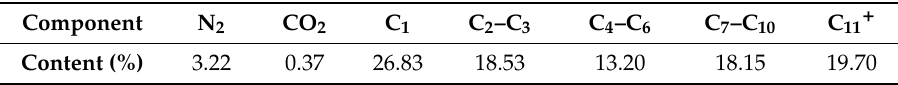
Table 2. Data of seven